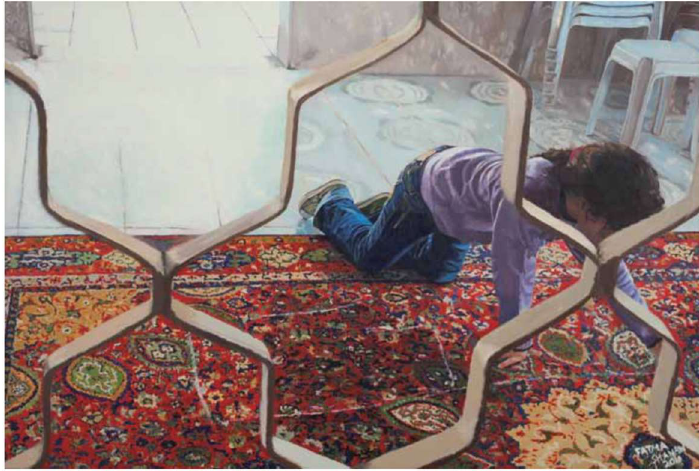
Figure 15. Fatma Shana, Manar 2 , 2010, oil on canvas, 80 × 100, private collection, Julis.